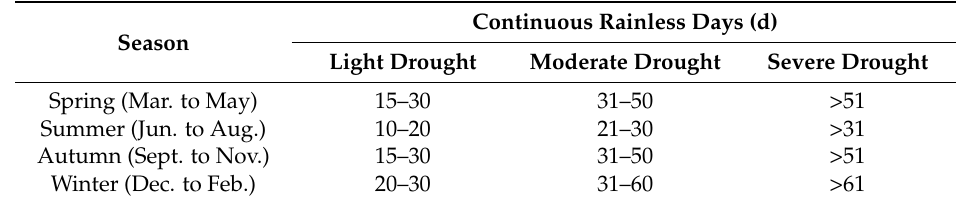
Table 2. Standard of classification for drought